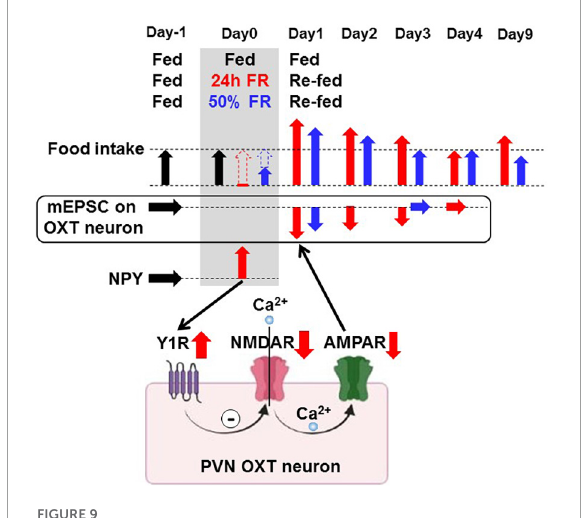
FIGURE9 Proposed mechanisms of food restriction-induced synaptic depression in paraventricular nucleus oxytocin neurons accompanied by hyperphagia. Neuropeptide Y, either elevated by 24 h /50% FR or administered, induces the Y1 receptor-mediated inhibition of glutamatergic synaptic input on PVN OXT neurons, the pathway possibly involving NMDAR and AMPAR. 24 h FR and 50% FR evoke this neuronal signaling and induce acute hyperphagia for 2–3 days on re-feeding. Twenty four hour FR but not 50% FR also induces late hyperphagia on Day 9 and